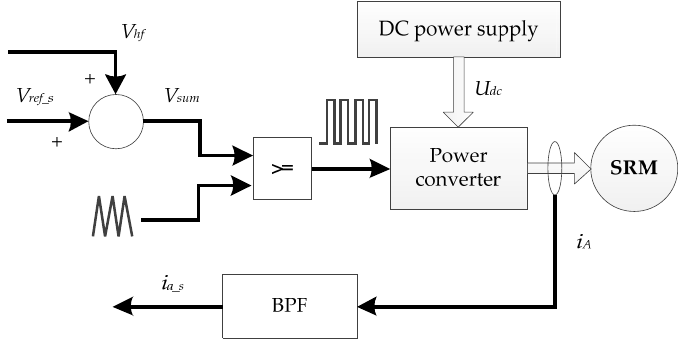
Figure 11. Schematic of the pulse injection method.